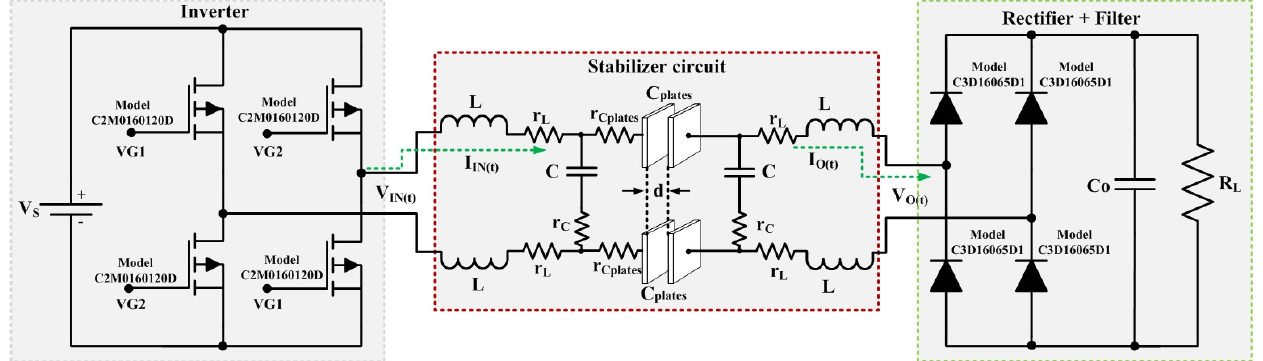
Figure 15. Complete circuit diagram.